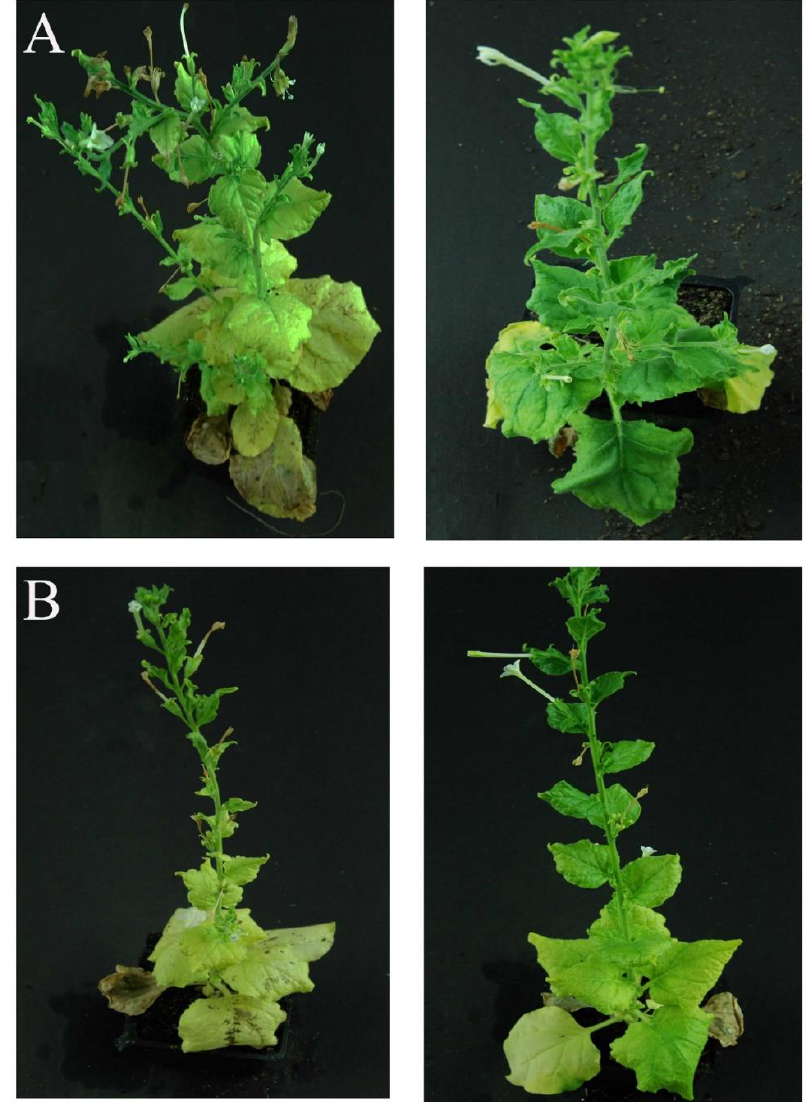
Figure 3. The mutated m03915 (m03915Nu, on right) and m04250 (m04250FS, on right) could not cause phloem necrosis, while m03915 (on left) and m04250 (on left) caused phloem necrosis at 5 WPI. ( A ) The mutated m03915 (m03915Nu, on right) could not cause phloem necrosis, while m03915 (on left) caused phloem necrosis at 5 WPI. ( B ) The mutated m04250 (m04250FS, on right) did not cause phloem necrosis, while m04250 (on left) caused phloem necrosis at 5 WPI.